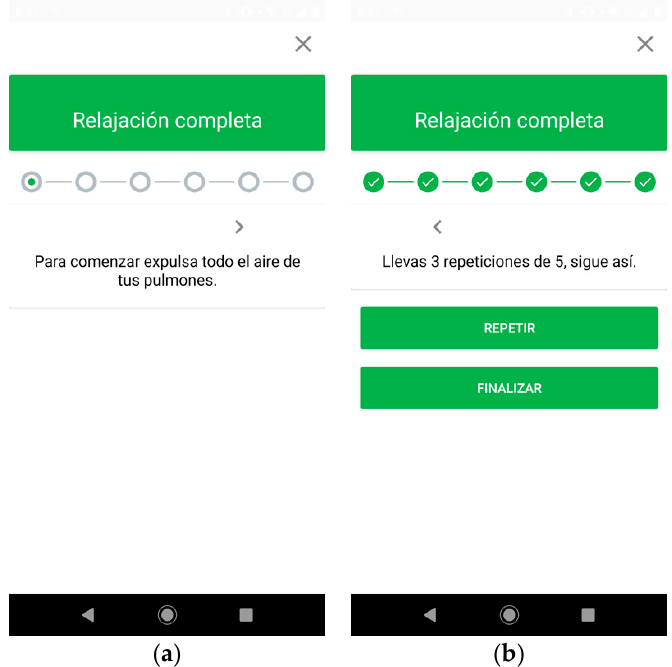
Figure 3. Screens of the user interface: ( a ) Exercise reward first screen and ( b ) Exercise reward when the patient had to do a